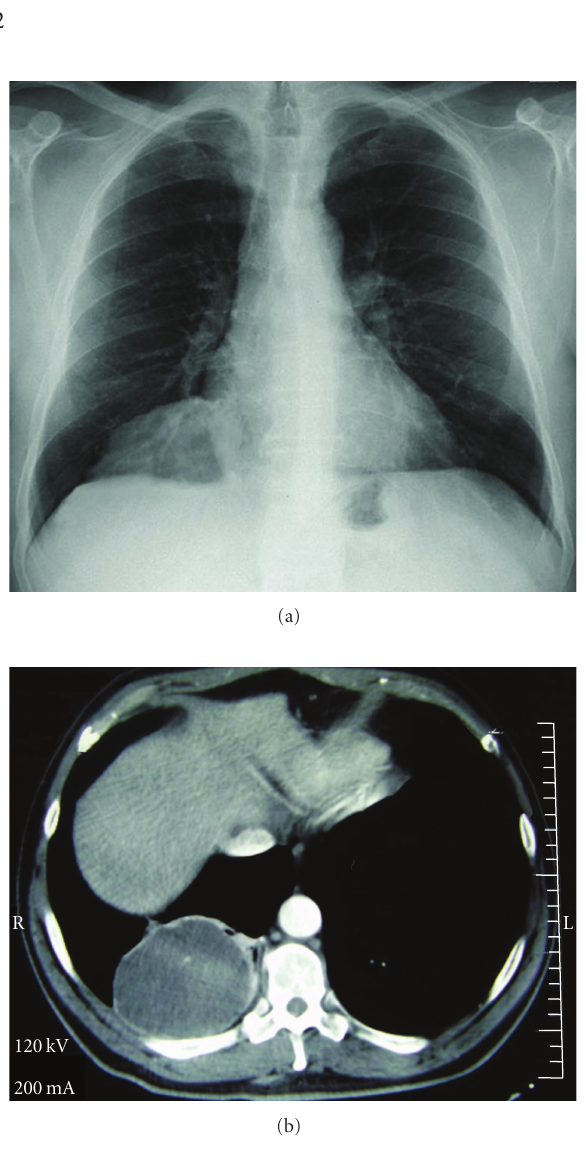
Figure 1: Primary PMCAC. (a) Chest X-ray revealing a solitary tumor in the right lower lobe of the lung. (b) Computed Tomog- raphy scan of the thorax. A large cystic well-demarcated mass in the right lower lobe of the lung is detected (19 Hounsfield Units).